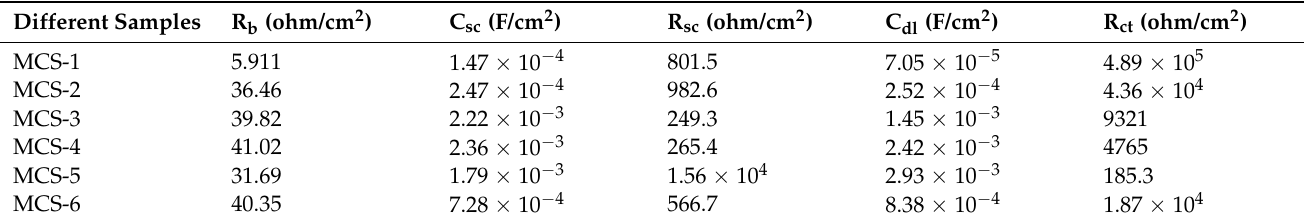
Figure 8. ( a ) Electrochemical impedance spectroscopy (EIS) and the equivalent circuit of MCS. ( b ) The periodic on/off photocurrent responses of MCS. Table 4. Equivalent circuit parameters of